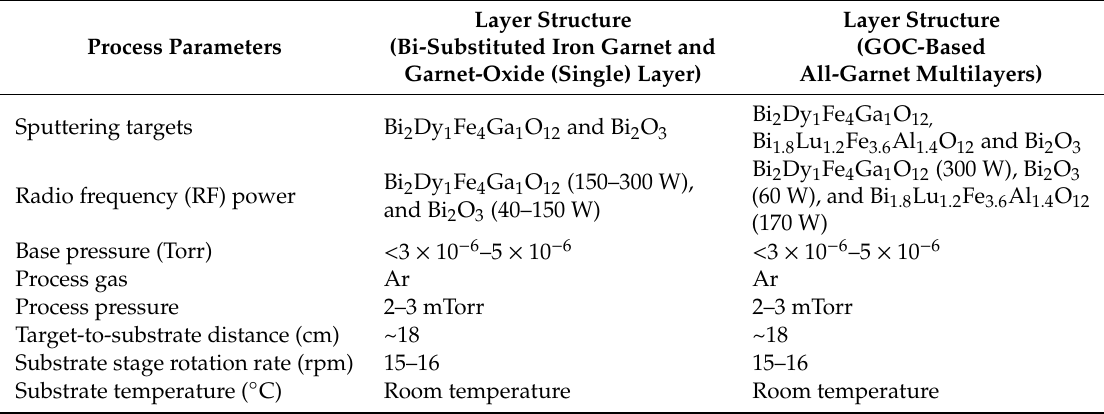
Table 1. Sputtering process parameters used to deposit garnet, garnet-oxide precursors (as single layer films), and all-garnet multilayer